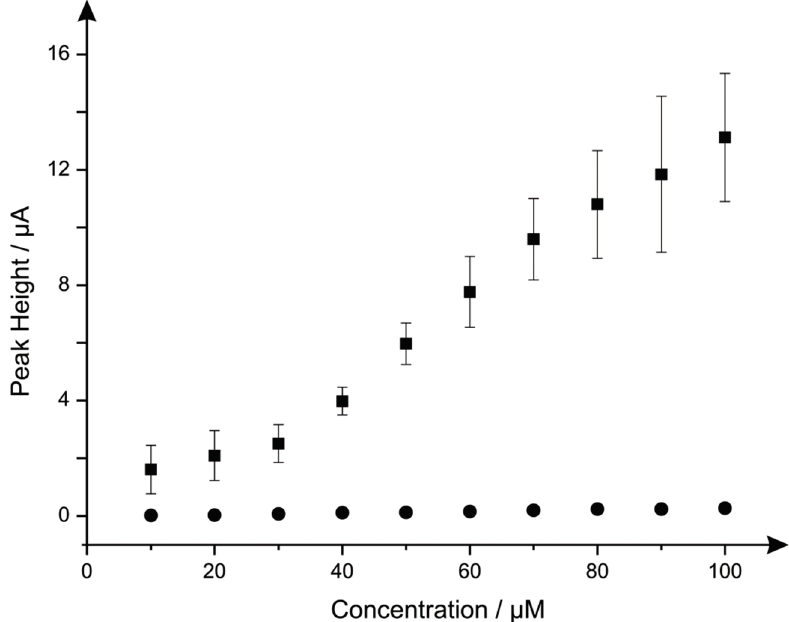
Figure 7. Calibration plots showing nano-CoTAPC SPE (squares) and CoPC-SPE (circles) towards additions of (10 µM to 100 µM) hydrazine into pH 7.4 PBS, utilising a new electrode after each addition. Scan rate: 100 mV s − 1 . In both cases error bars are presented for nano-CoTAPC SPE (squares) and CoPC-SPE (circles) responses where the average of three measurements and standard-deviations are